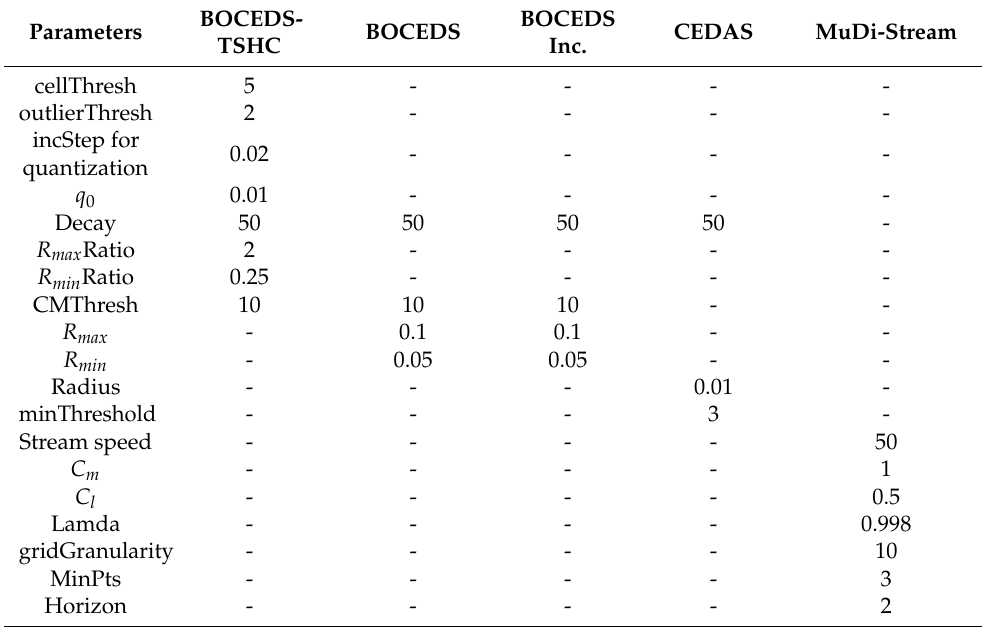
Table 1. Parameters Setting.